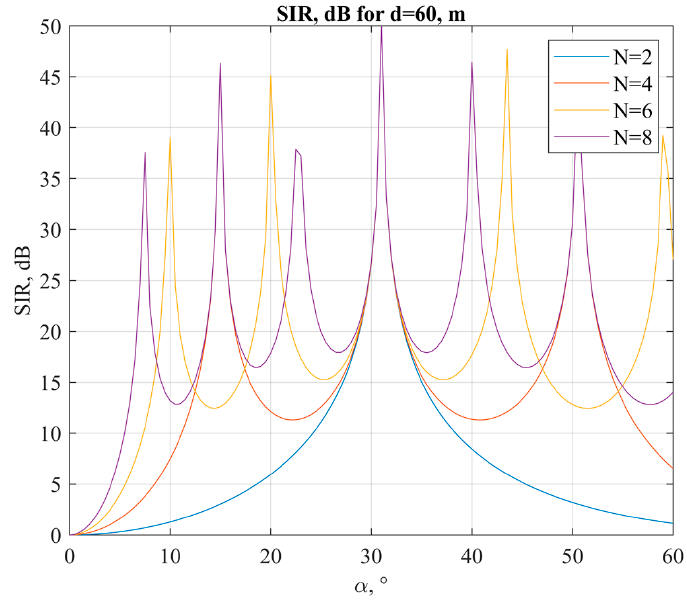
Figure 4. Dependence of SIR on angular separation at a given range.